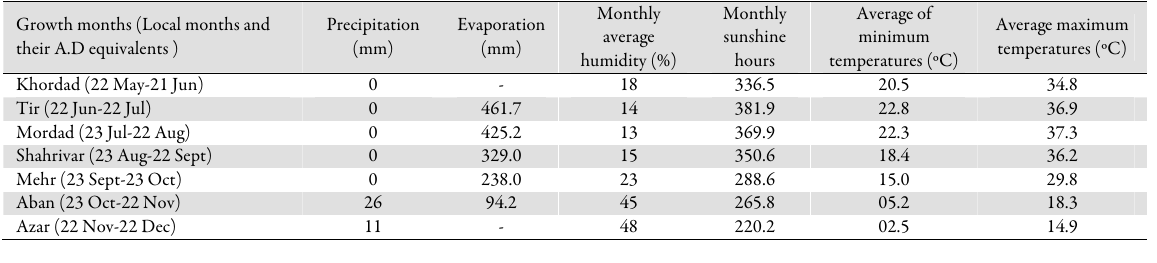
Table 2. The main properties of superabsorbent polymer (potassium polyacrylate and polyacrylamide